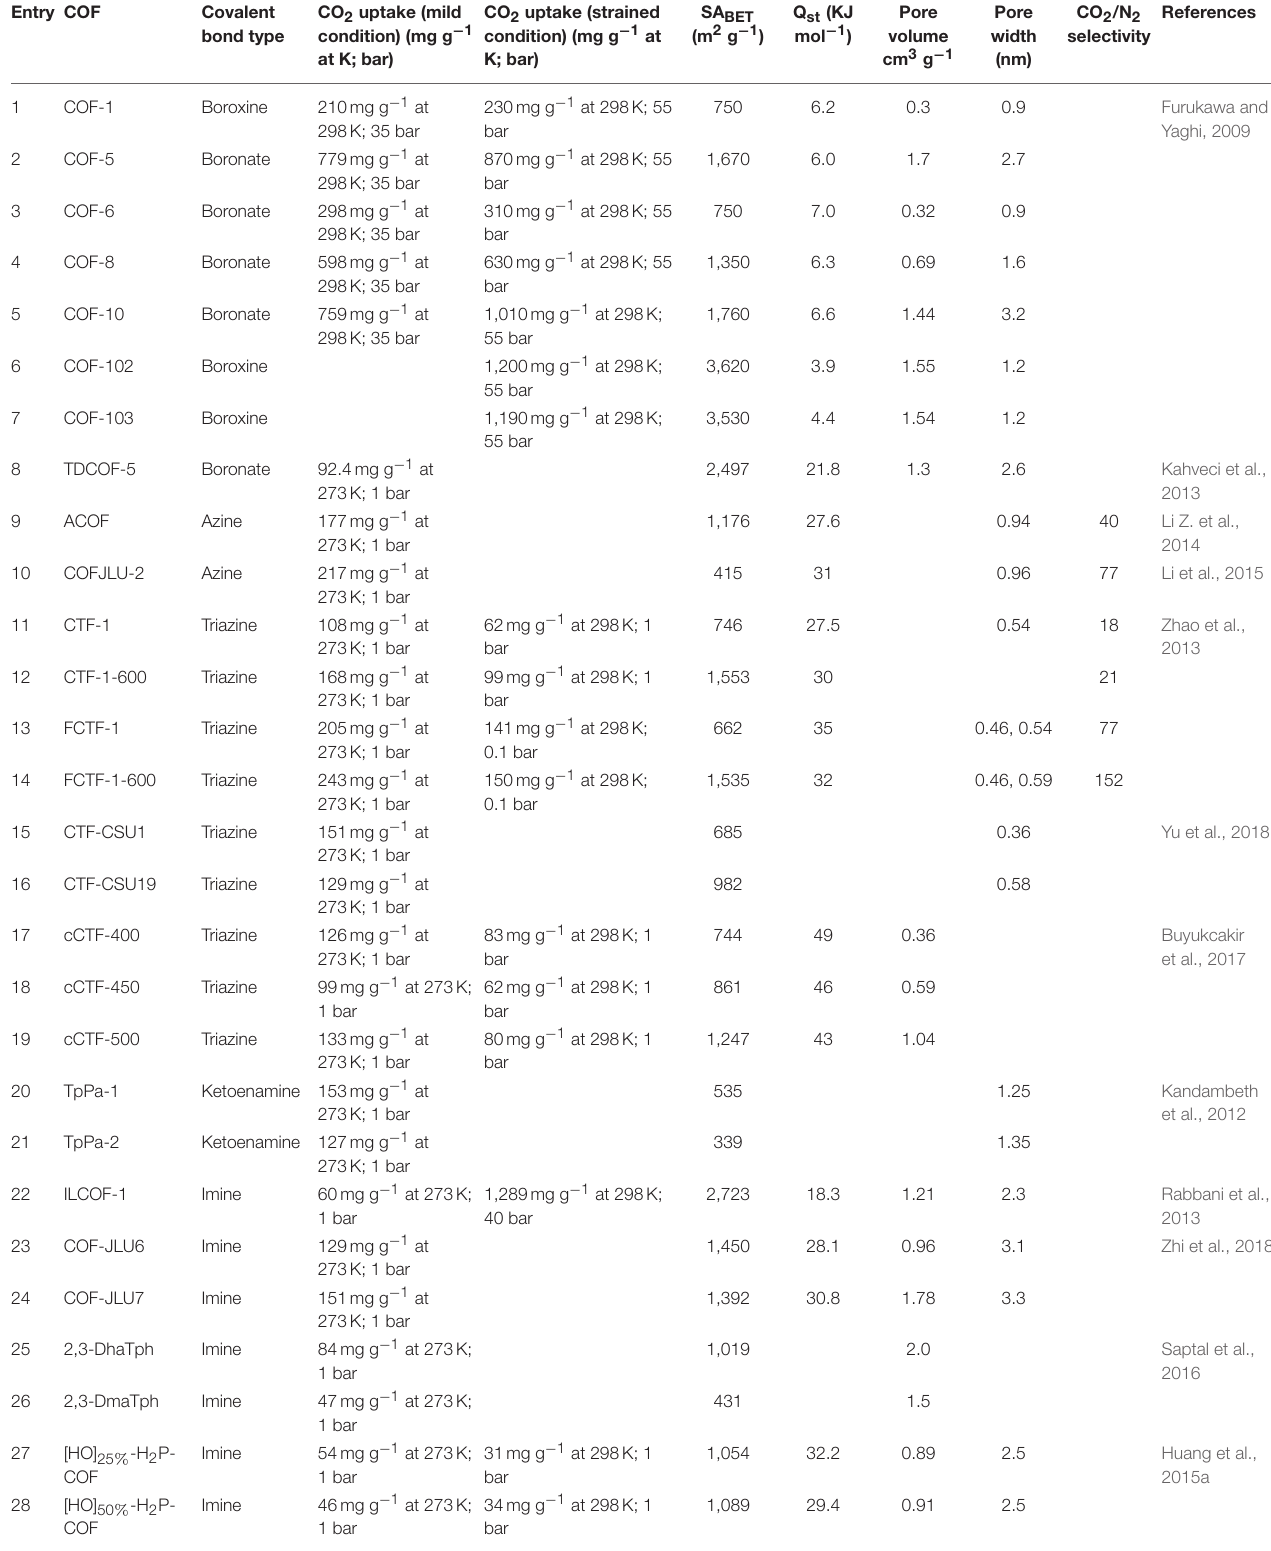
TABLE 1 | COFs for CO 2